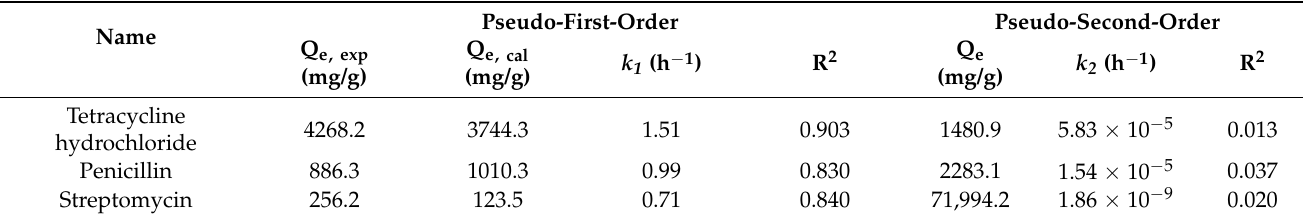
Table 2. The adsorption kinetic parameters of three antibiotics on